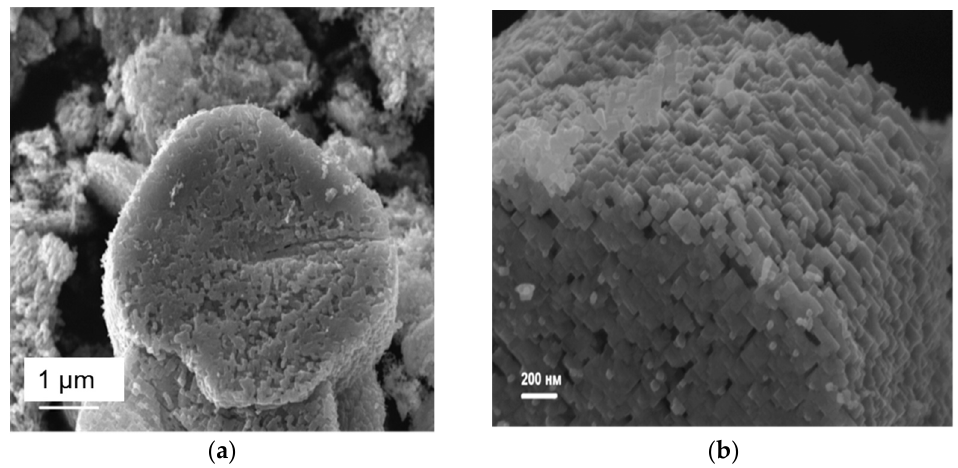
Figure 4. Scanning electron micrographs of a sample of TiO 2 mesocrystals generated from a sample of NH 4 TiOF 3 by heating under argon at 450 ◦ C for 2 h: ( a ) showing porous layered structure of a collection of mesocrystals (white scale bar = 1 µ m) and ( b ) an expanded image of a single TiO 2 mesocrystal showing individual component nanoparticle building blocks comprising the mesocrystal (white scale bar = 200